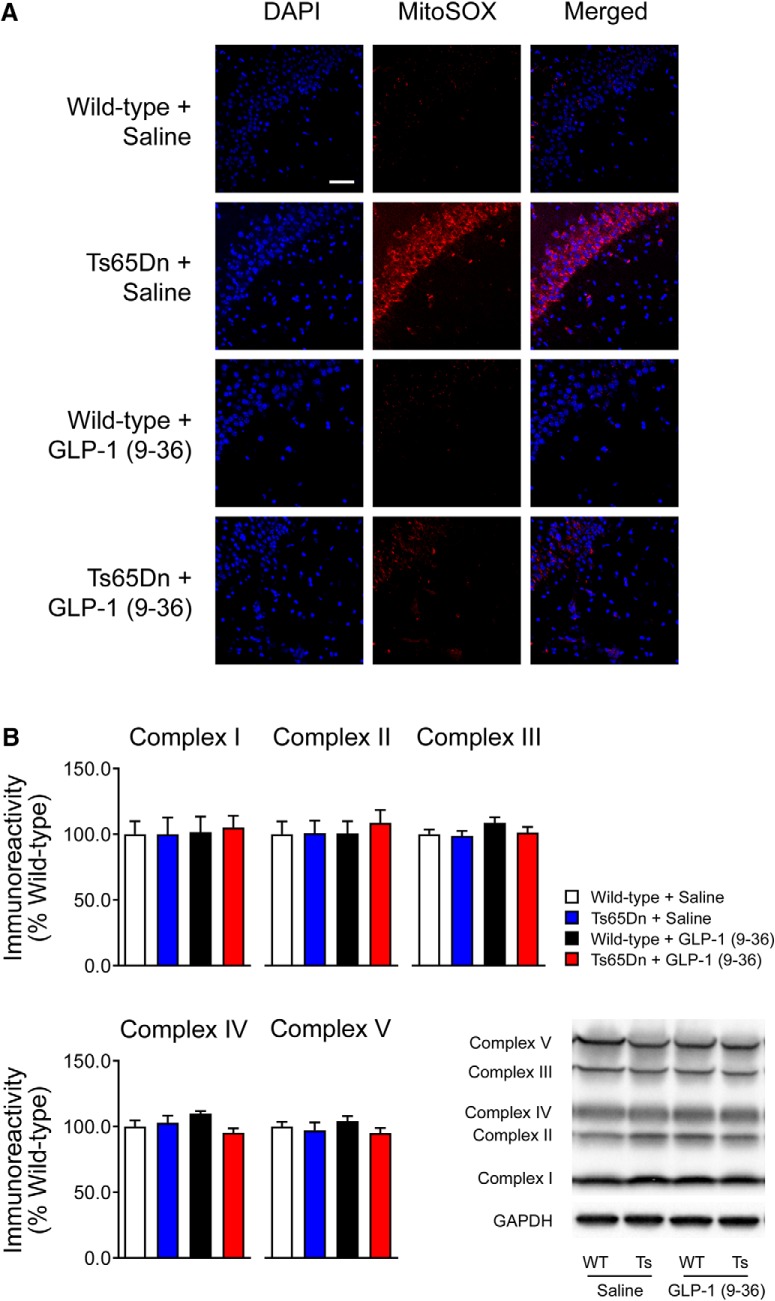
GLP-1 (9-36) treatment normalizes increased hippocampal mitochondrial superoxide in Ts65Dn mice. A, The MitoSOX fluorescent signal (red) was increased in area CA1 of hippocampal slices from Ts65Dn compared with slices from WT mice. GLP-1 (9-36) treatment normalized the DS-associated increased fluorescent signal. Results are representative of three independent experiments (20×, scale bar, 50 μm; n = 3 per group). B, Western blot experiment revealed no significant difference in the expression of oxidative phosphorylation complex proteins among all four experimental groups (n = 8 per group).